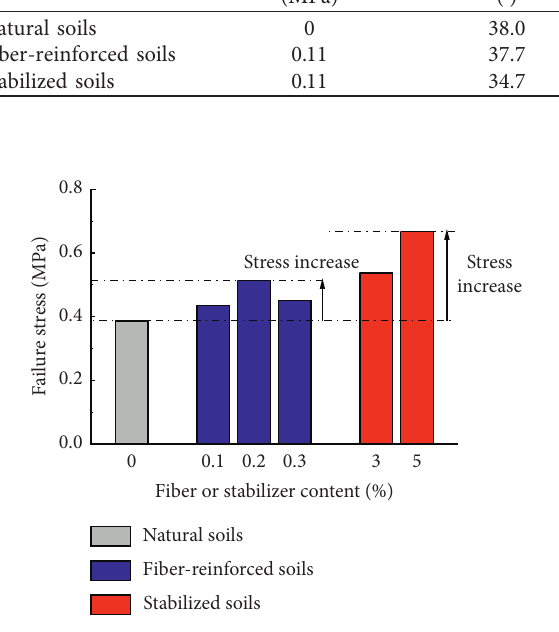
Figure 21: Failure stress for different soils (confining pressure � 0.1 MPa).